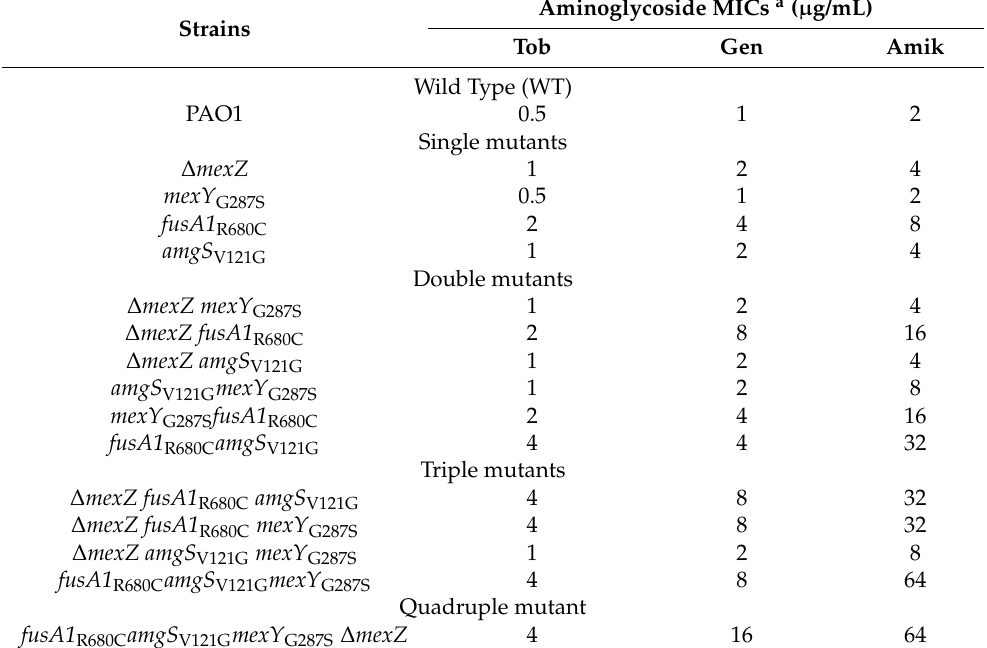
Table 2. MICs of engineered